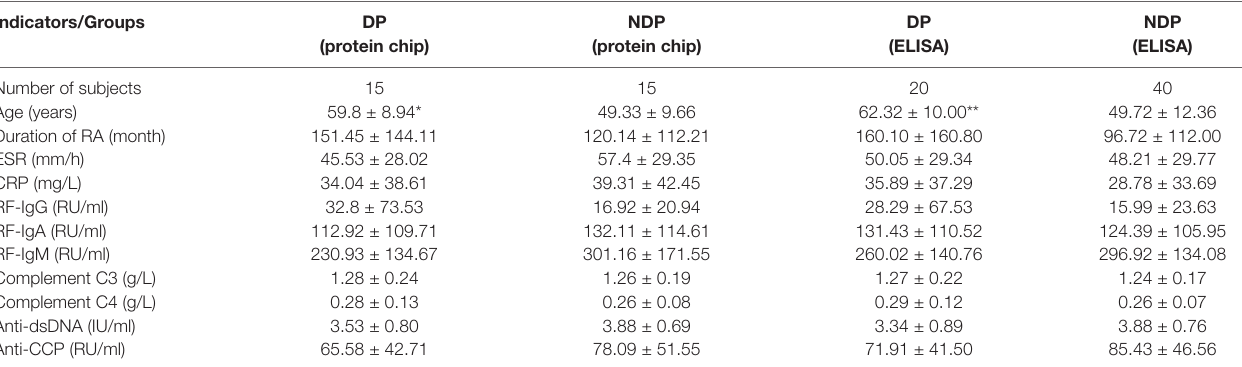
TABLE 1 | Characteristics among the groups of enrolled subjects.